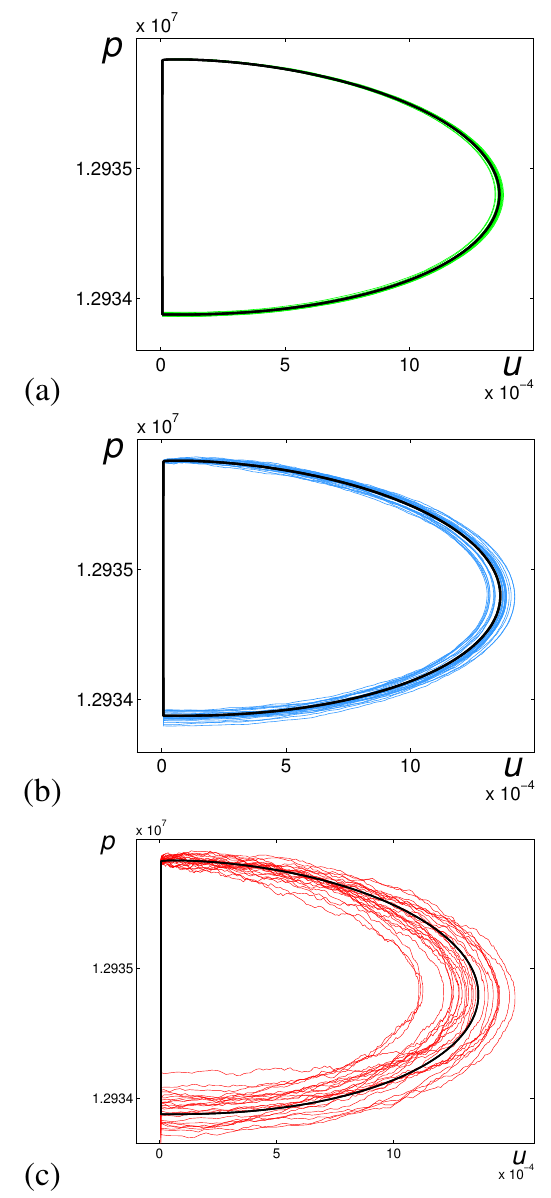
Figure 8. Stochastic cycles p (Pa) vs. u (ms − 1 ) for δ = 0 . 1 (a) , δ = 0 . 5 (b) , and δ = 2 (c) .